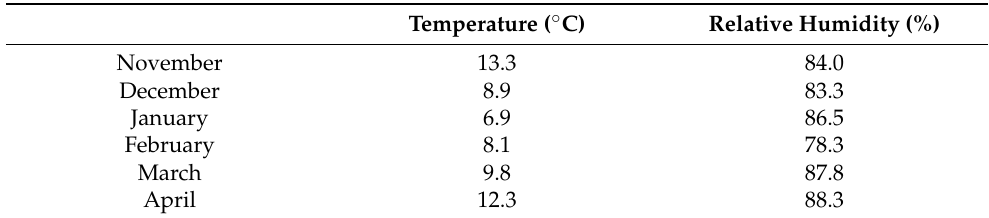
Table 2. Monthly nighttime average values for temperature and relative humidity during the ex-